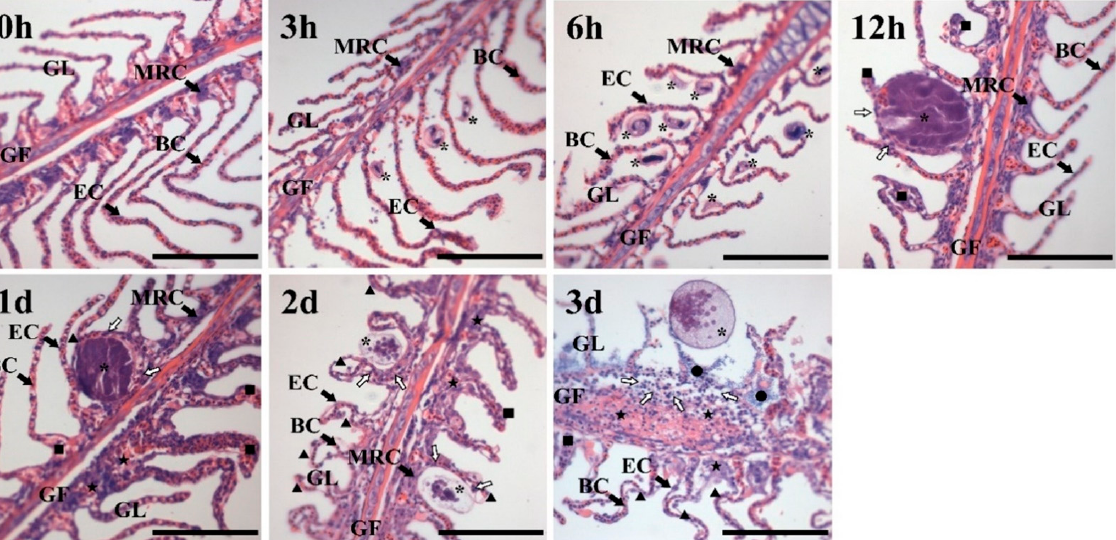
Figure 1. HE staining of the gill tissue of T. ovatus infected by C. irritans. Abbreviations: GF: gill